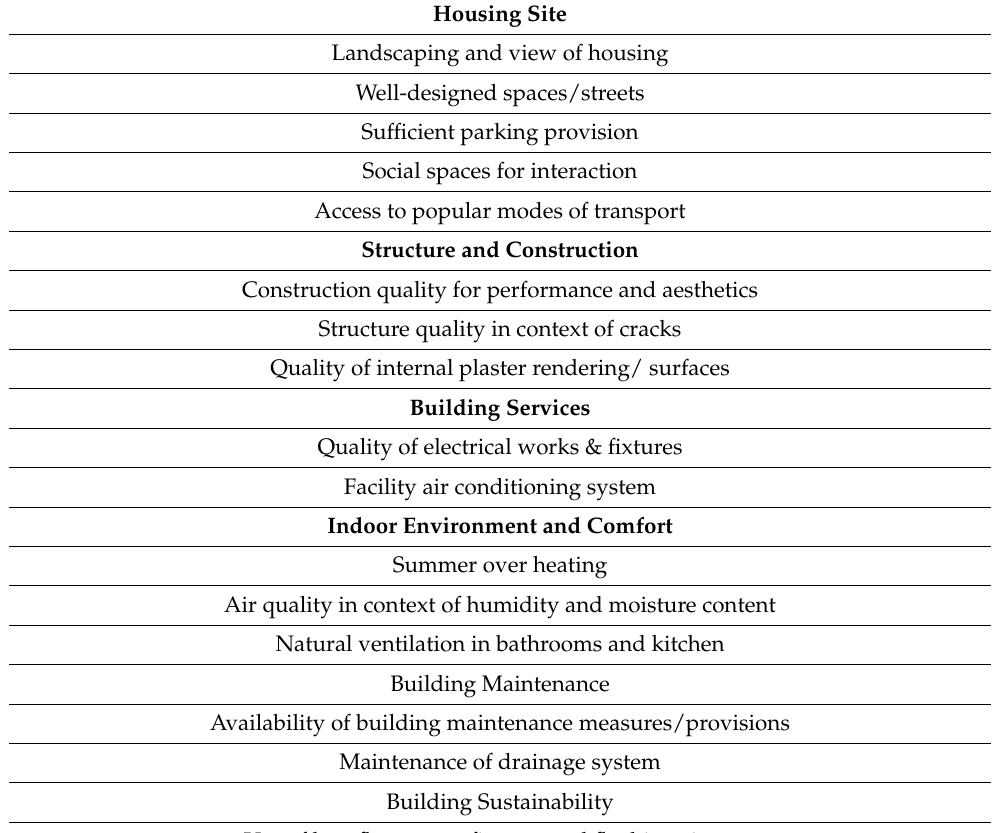
Table 4. Issues of poor design in affordable